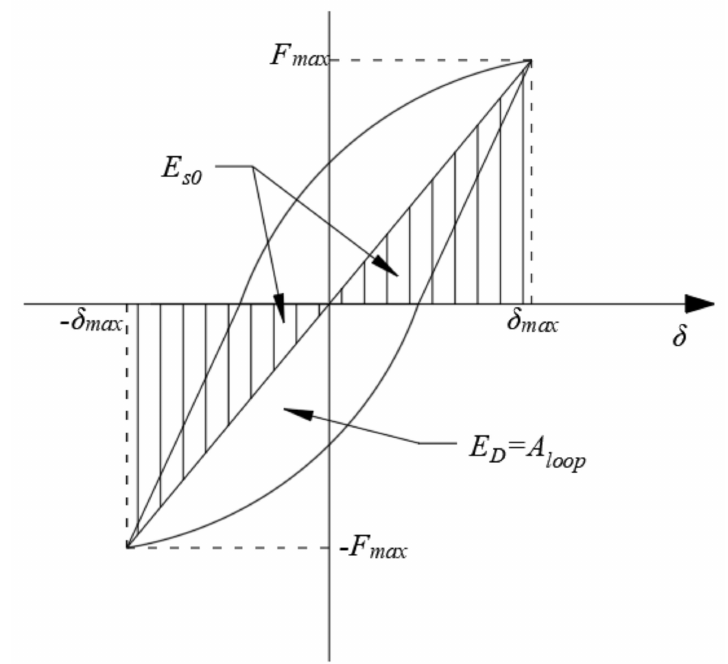
Figure 26. Determination of equivalent hysteretic damping ratio.